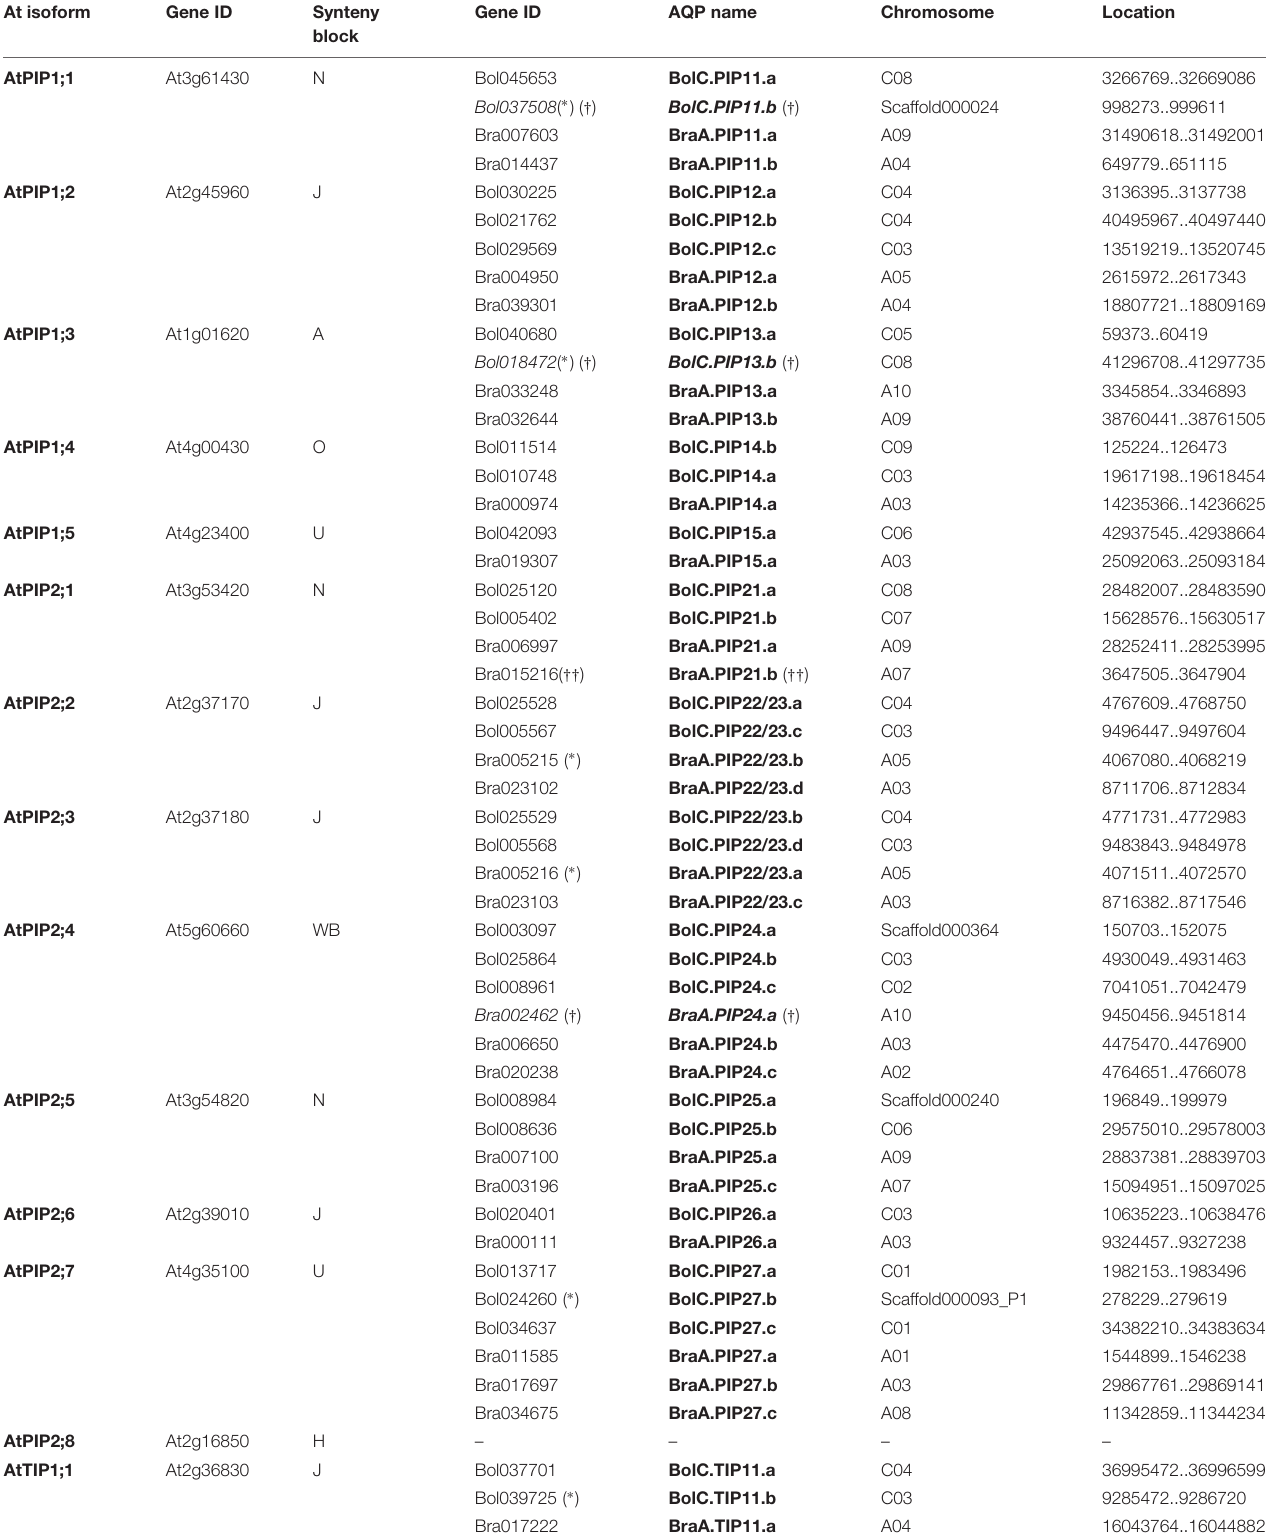
TABLE 1 | List of all Arabidopsis thaliana, Brassica oleracea, and Brassica rapa AQP genes and their distribution on chromosomes. At